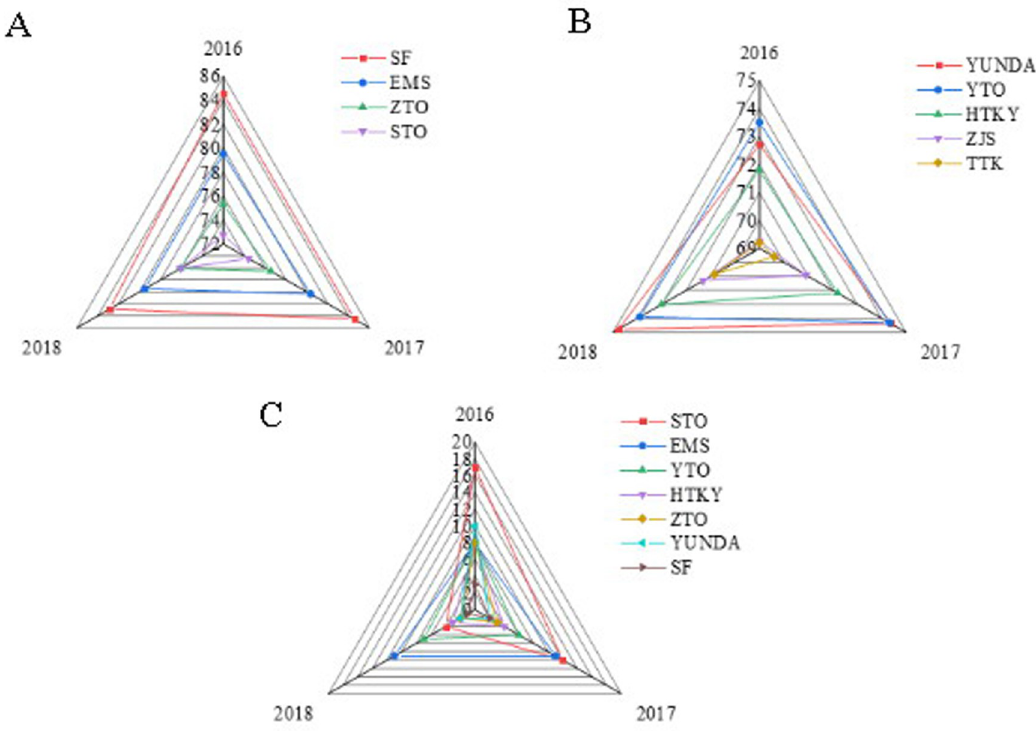
Fig 7. Comparison of horizontal capabilities of Chinese express enterprises in terms of non-financial